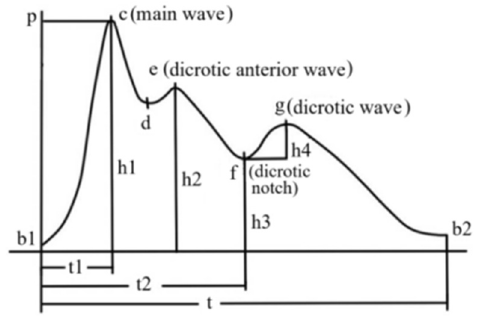
Figure 2. Key feature points of pulse wave.